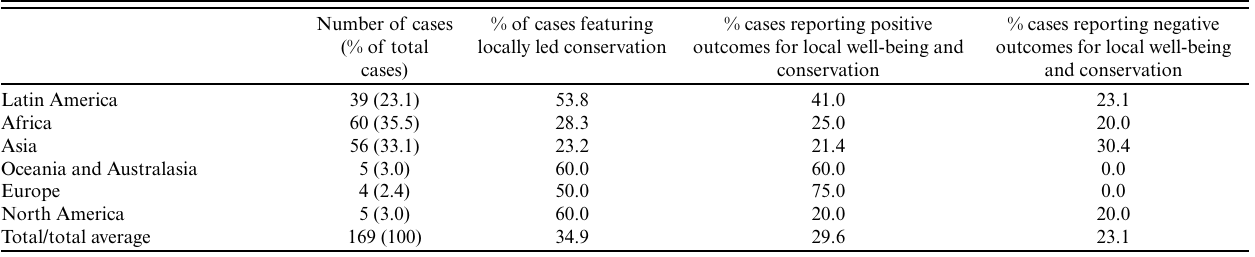
Table 3 . Geographic distribution of the 169 cases presented in the reviewed studies and their key findings disaggregated by